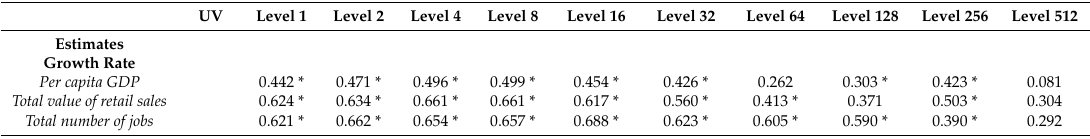
Table 3. Relationships between mean city-based urbanization velocity (UV) analysis results and socio-economic indicators across multiple scales.